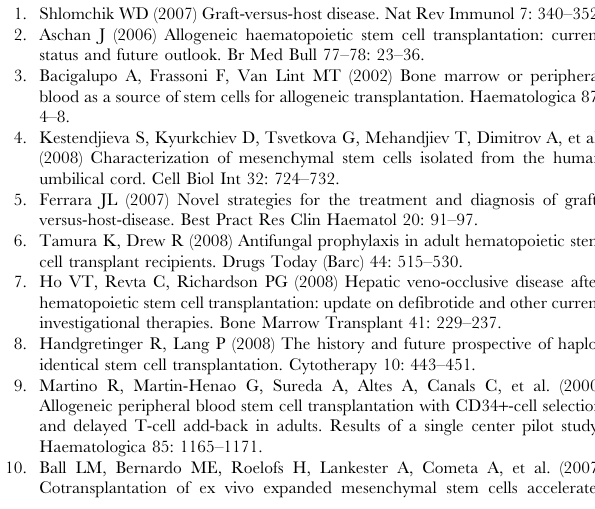
Figure S1 Development of non-linear regression models of function parameter = function (dose, time) for red blood cell count (RBC) and determination of the lethal irradiation dose. (A) Time was modeled using exponential decay and sigmoidal increase or decay. Both functions are related to typical damage processes and growth processes, respectively. (B) Groups of four mice were irradiated with X-Rays (0 Gy, 3 Gy, 6 Gy, 8 Gy, 12 Gy). Survival for doses $ 8 Gy is significantly shorter than for doses , 8 Gy.